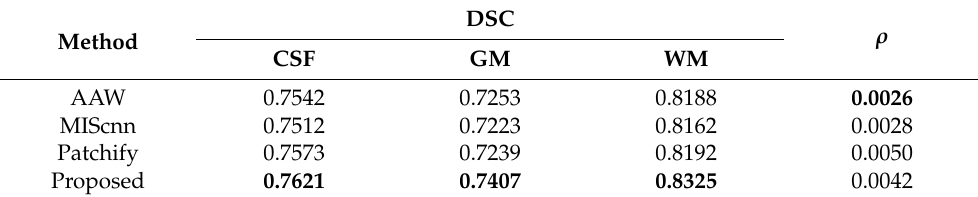
Table 2. Registration results of different fusion methods and the best results are shown in